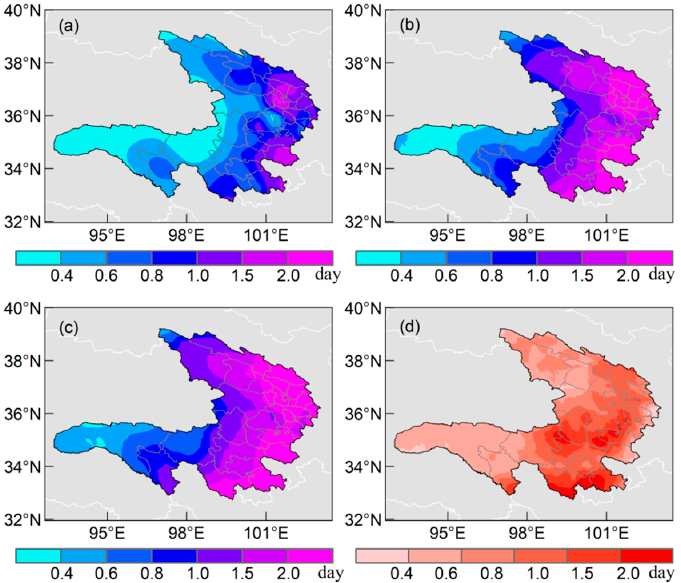
Figure 7. Spatial distribution of rainstorm days around 2050 (2036–2065) in the upstream of Yellow River Basin in future scenarios: ( a ) low-emission scenario SSP126, ( b ) medium-emission scenario SSP245, ( c ) high-emission scenario SSP370, ( d ) the difference in rainstorm days between high- and low-emission scenarios.